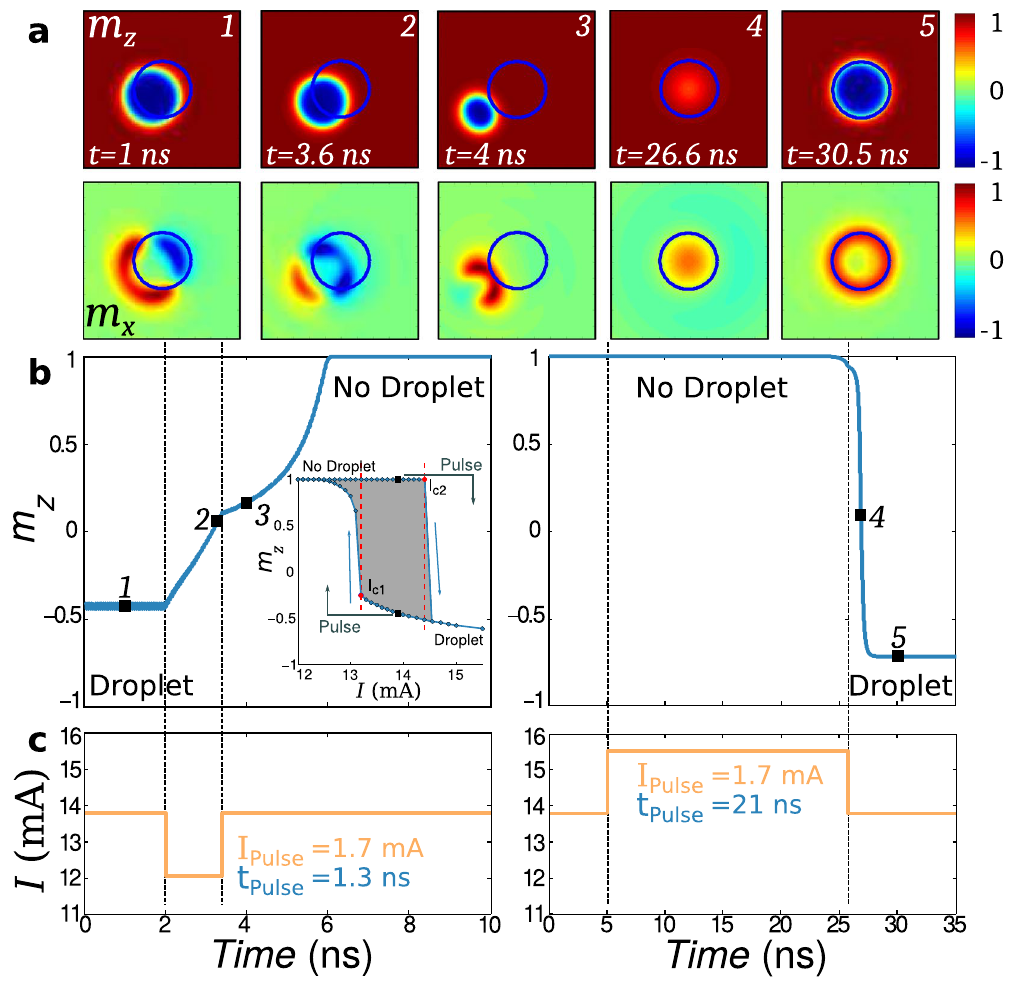
Figure 4. Creation and annihilation process. ( a ) Images of the magnetization at times in the simulation. Images correspond to a 290 × 290 nm 2 field of view. The blue circle shows the boundary of the nanocontact. ( b ) Time evolution of the nanocontact magnetization for the annihilation and the creation processes, left and right images, respectively. The black squares correspond to the times shown in the images. ( c ) Current applied as a function of time for the annihilation and generation processes. The vertical dashed black lines shows the time where the pulse was applied. The inset of ( b ) left hand panel, shows the average magnetization of the nanocontact as a function of the current and the resulting hysteresis: I c 1 = 13.1 mA and I c 2 = 14.5 mA and between these currents both droplet and non-droplet states are